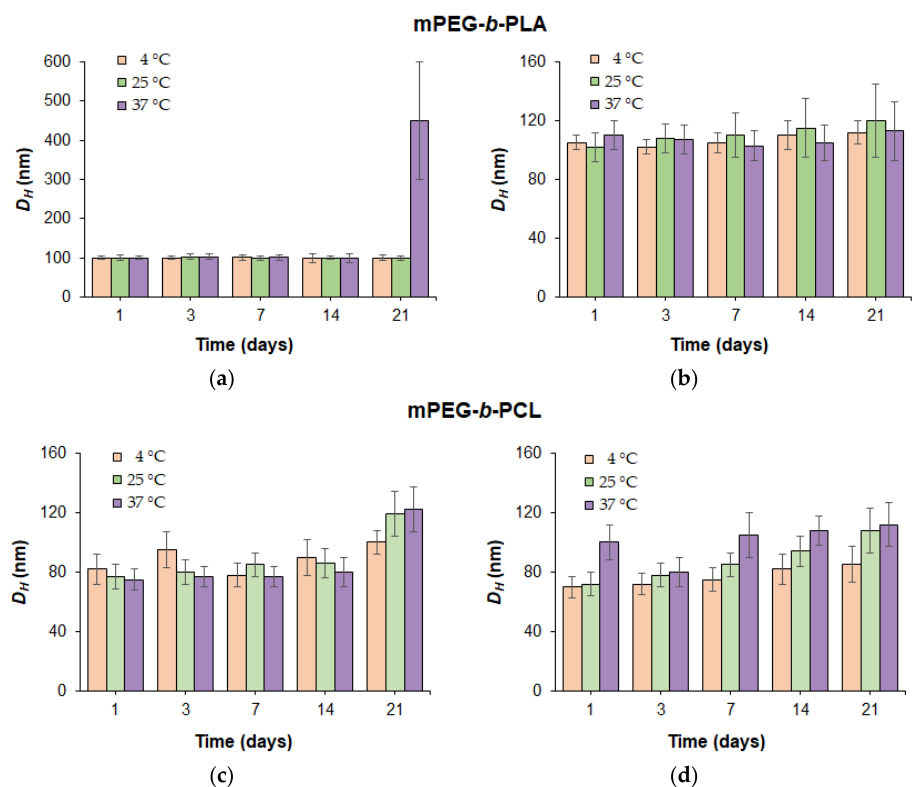
Figure 4. Dependence of the hydrodynamic diameters for mPEG- b -PLA ( a , b ) and mPEG- b -PCL ( c , d ) nanoparticles in deionized water ( a , c ) and 0.01 M PBS (pH 7.4) ( b , d ) on the incubation time at different temperatures.